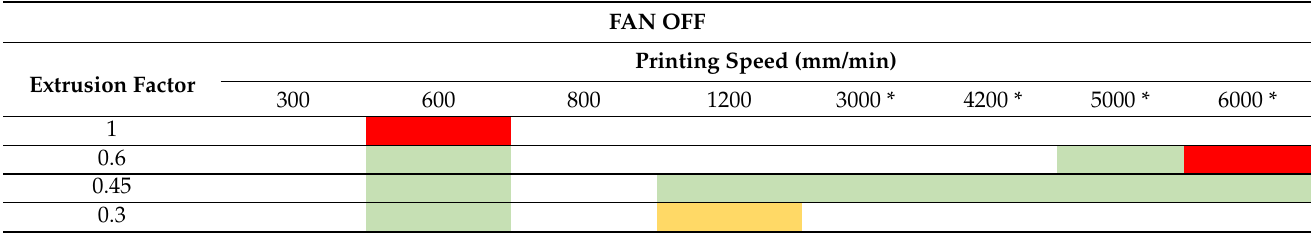
Table A1. Summary of results with the fan switched